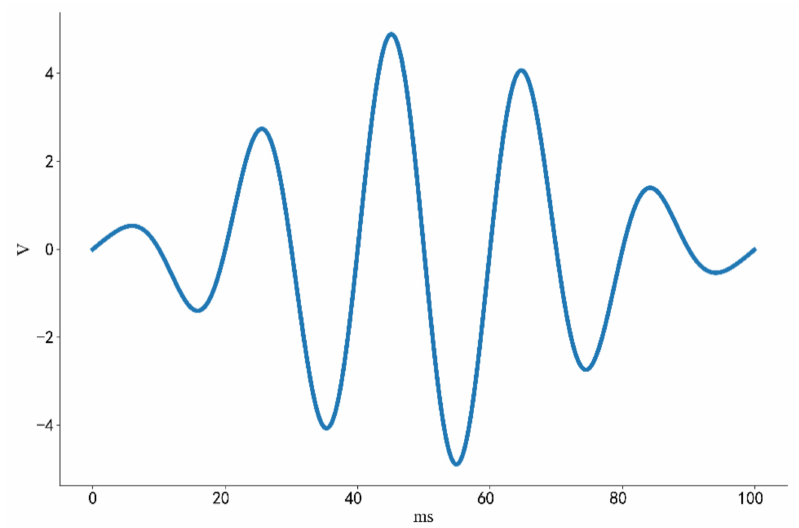
Figure 5. Emission